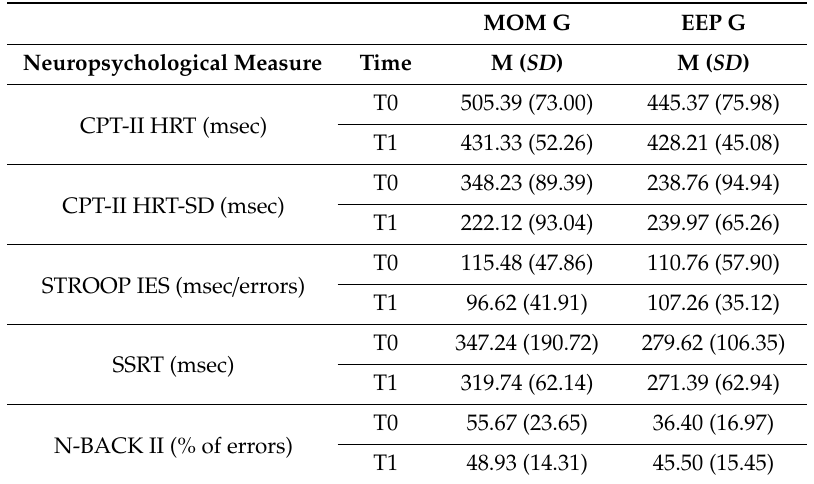
Table 1. Means and Standard Deviations of Neuropsychological Measures in the Mindfulness-Oriented Meditation Group and in the Emotion Education Program Group. MOM G EEP